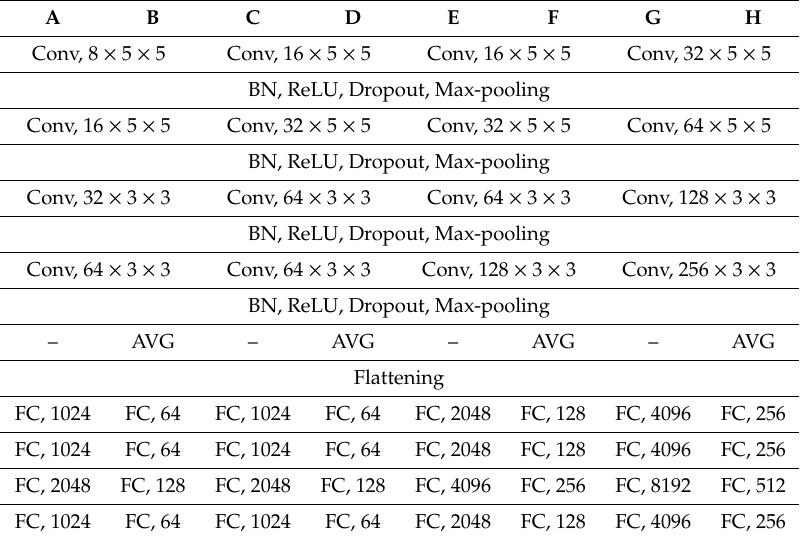
Table 9. Summary of di ff erent network structures.